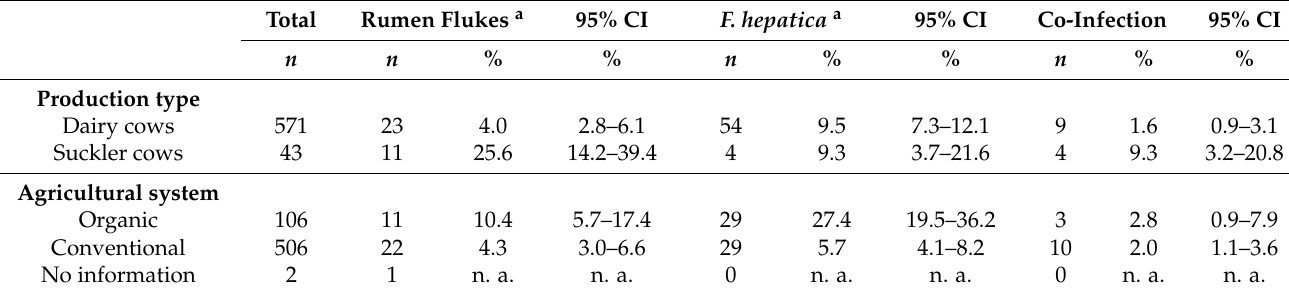
Table 3. Prevalence of patent rumen fluke, F. hepatica and co-infections in German cattle farms ( n = 614) related to the management factors production type and agricultural system. Note that percent calculation was omitted if less than five farms (total values) were included.